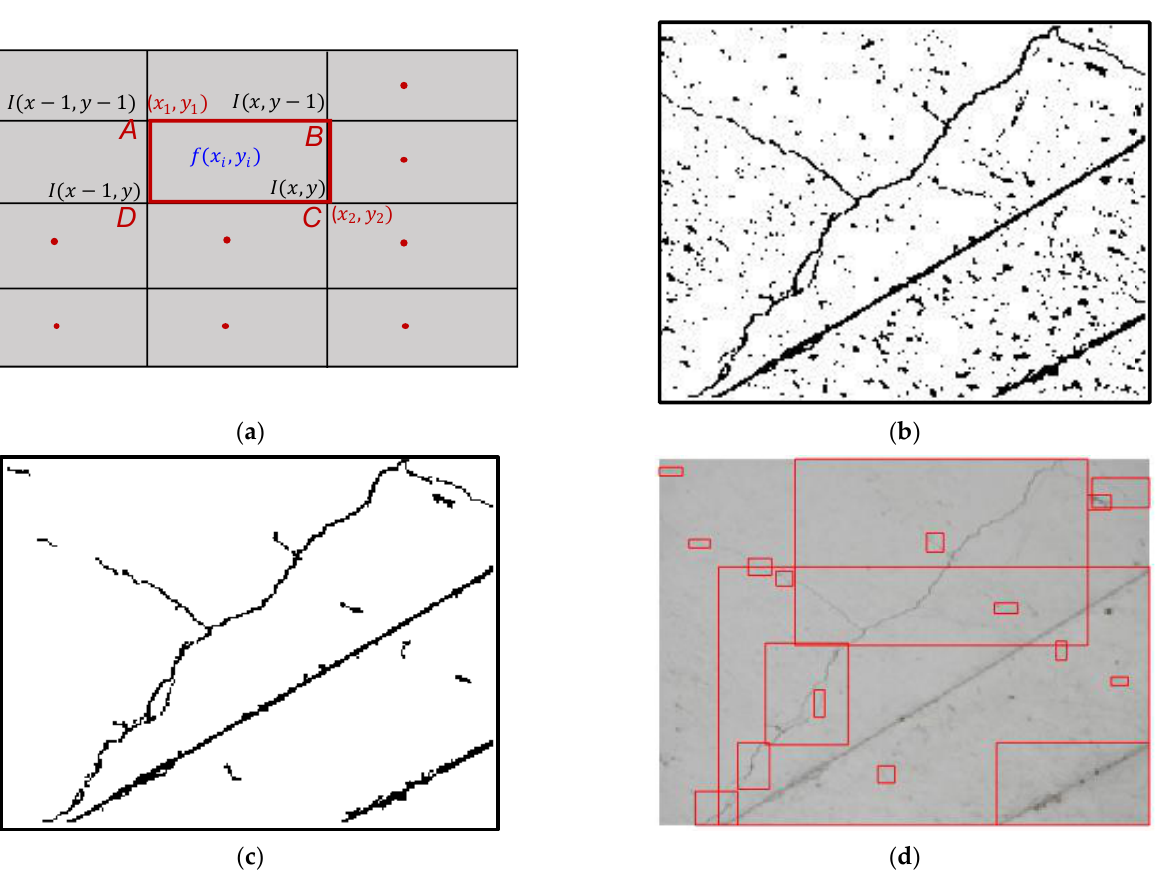
Figure 1. ( a ) Schematic representation for an integral image, and ( b ) results for local-threshold-based image binarization. ( c ) Filtering surface texture and optical noise using aspect ratio of crack, and ( d ) crack candidate regions (CCRs) mapped (marked in red color) to original RGB image. For a square window of size s , the local threshold T ( x , y )